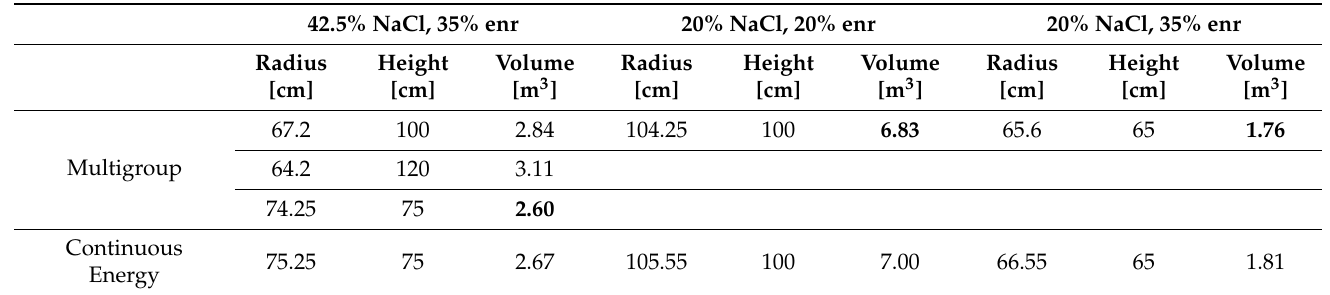
Table 3. Studied cases for the 3-D Monte-Carlo analysis to determine the minimum volume required to achieve a critical configuration.